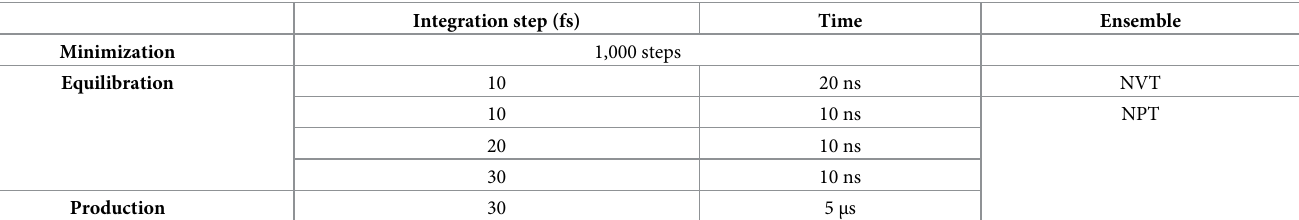
Table 1. Protocol of the coarse-grained MD